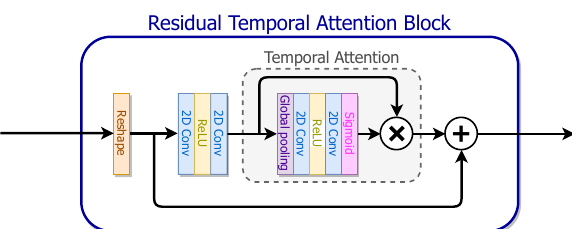
Figure 3. Reference architecture of a residual temporal attention block. If the number of channels C (cid:54) = 1 the input tensor X ( i ) is reshaped in H × W × ( T · C ) . Consequently, all temporal channels are weighted with some statistics computed by the layers of the temporal attention